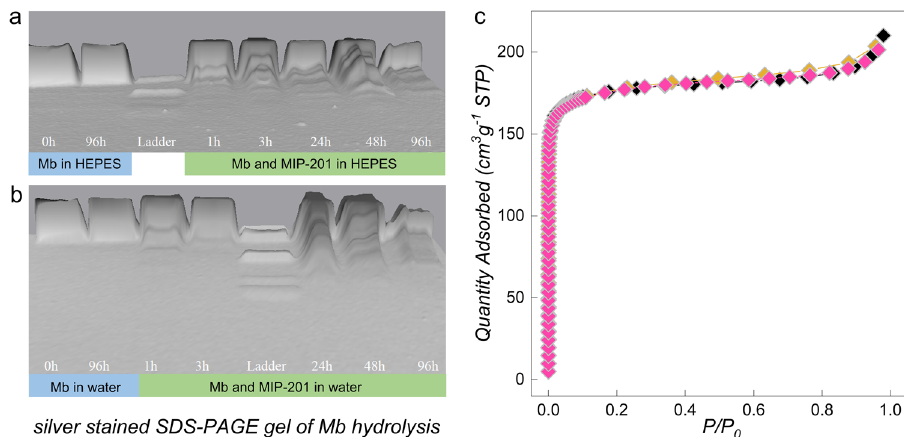
Fig. 4 Hydrolysis of horse-heart myoglobin (Mb) catalyzed by MIP-201. a Silver stained SDS-PAGE gel of Mb hydrolysis in the presence of MIP-201 in HEPES buffer (pH 7.4 and at 60 °C). b Silver-stained SDS-PAGE gel of Mb hydrolysis in the presence of MIP-201 in water (pH at 7.4 and at 60 °C). c Nitrogen adsorption isotherms of MIP-201 samples before (black square) and after the application in hydrolysis of Mb in HEPES buffer (orange square) and water (pink